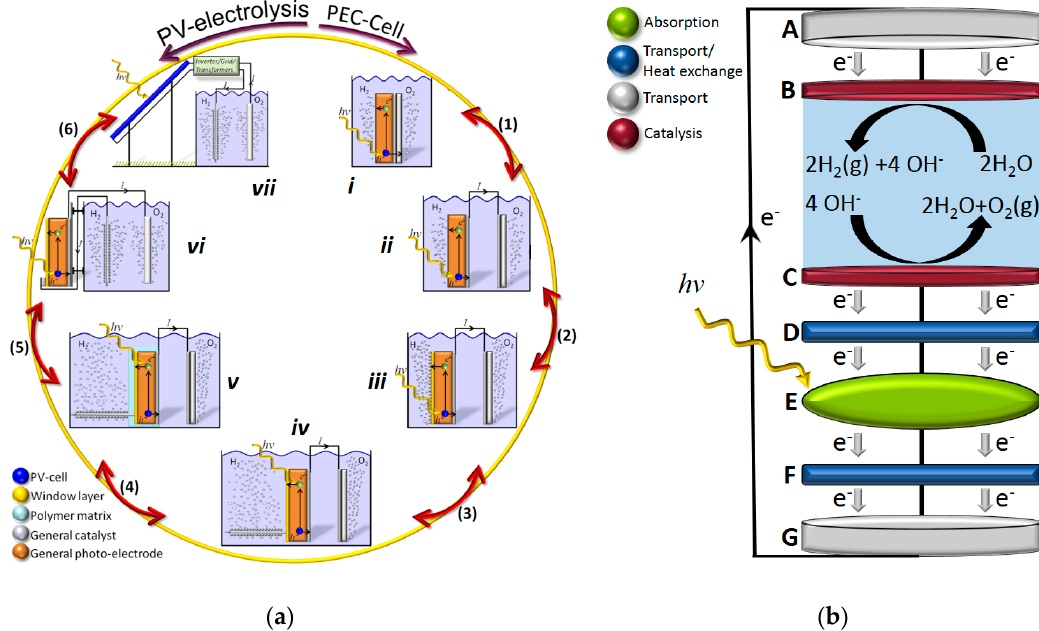
Figure 1. ( a ) General scheme for the relation between photoelectrochemical (PEC) and photovoltaic (PV)-electrolysis, where designs from i to vi can be utilized for thermally integrated approaches while vii requires an externally driven flow system. Adapted with permission from [4], The Royal Society of Chemistry, 2014. ( b ) A schematic illustration of integrated solar driven electrolysis using normal or concentrated solar light and thermally coupled functions in layer D and F.